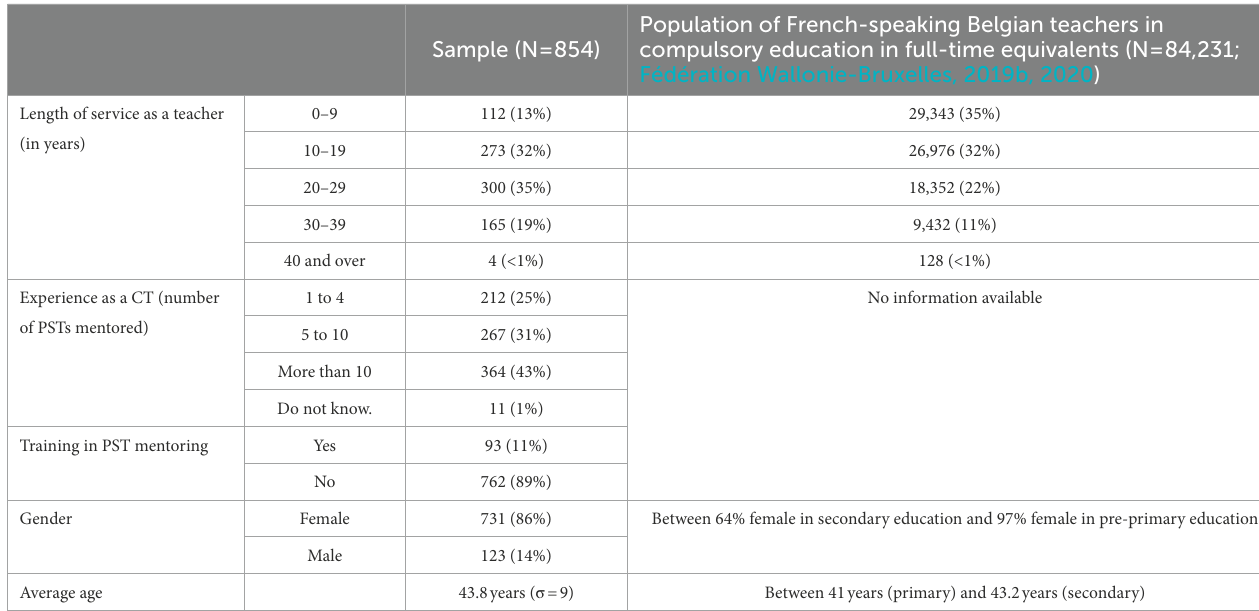
TABLE 2 Description of the sample (Baco et al., 2022a, p: